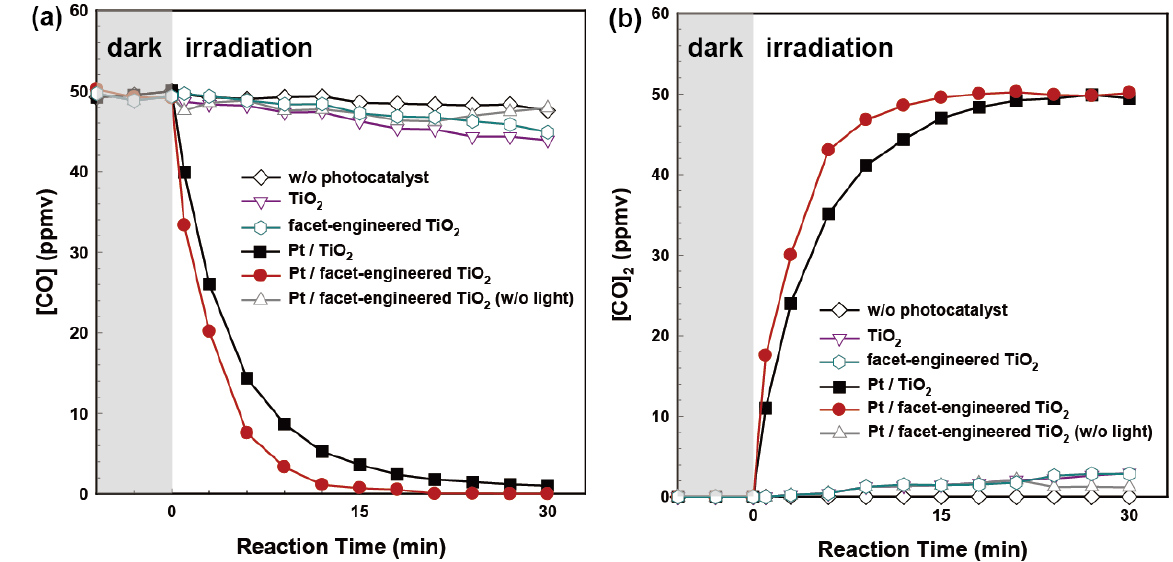
Figure 3. Time-dependent profiles of ( a ) photocatalytic oxidation of CO and ( b ) the concurrent production of CO 2 on TiO 2 , facet-engineered TiO 2 , Pt/TiO 2 , Pt/facet-engineered TiO 2 , and control experiments (with/without photocatalyst film or irradiation). Experimental conditions: catalyst film size = 2 × 2 cm 2 , light source = UV LED (370 nm), and [CO] 0 = 50 ppmv. Each oxidation experiment consisted of 10 min for adsorption equilibrium (dark) and 30 min for UV irradiation.